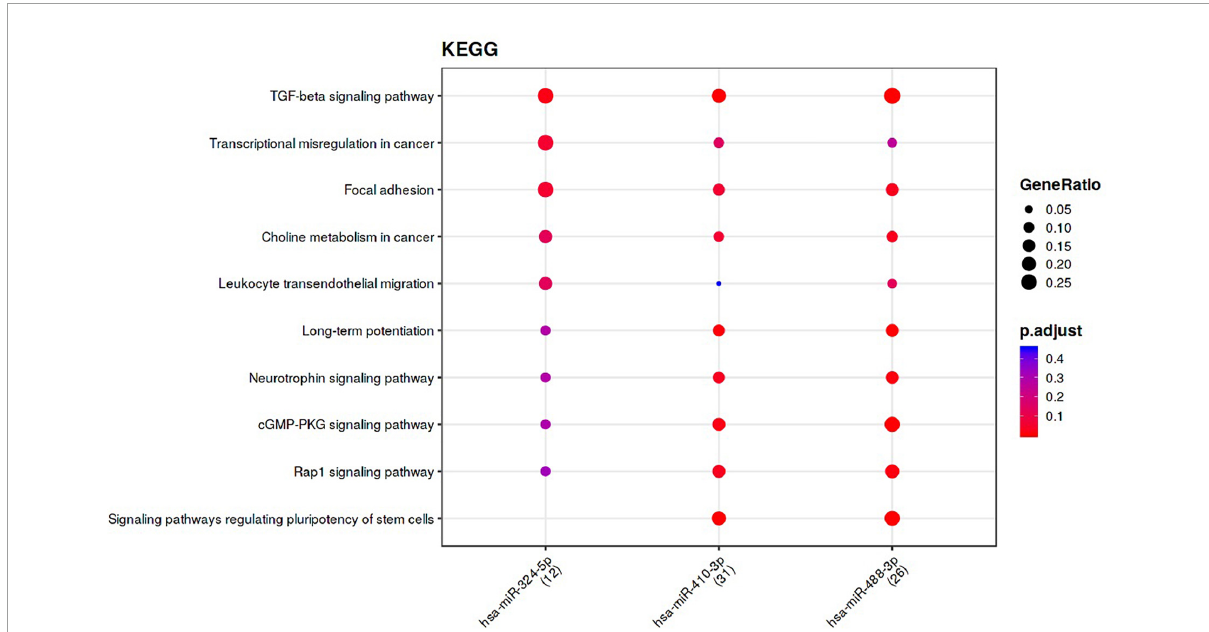
FIGURE5 Functional enrichment analysis performed with target genes of the most relevant miRNAs among 9 miRNAs of the DCI comparison, from Target Gene database, using KEGG pathways. The specific miRNAs are shown in x-axes and the pathways obtained with the genes that have interactions with the selected miRNA are shown in the y-axes. The gene ratio is represented by the size of the dot and the color indicates the p-value adjusted by